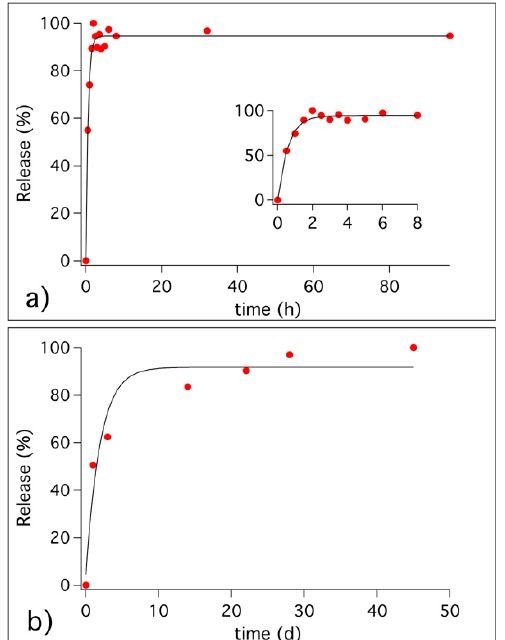
Figure 8. Release kinetic of BTA from HNTs: ( a ) release in simulated pore solution and zoom of the data collected in the first hours; ( b ) release in S4H8 cementitious formulation. Experimental data are reported as red markers, while black lines represent the exponential curves used to fit the collected data.